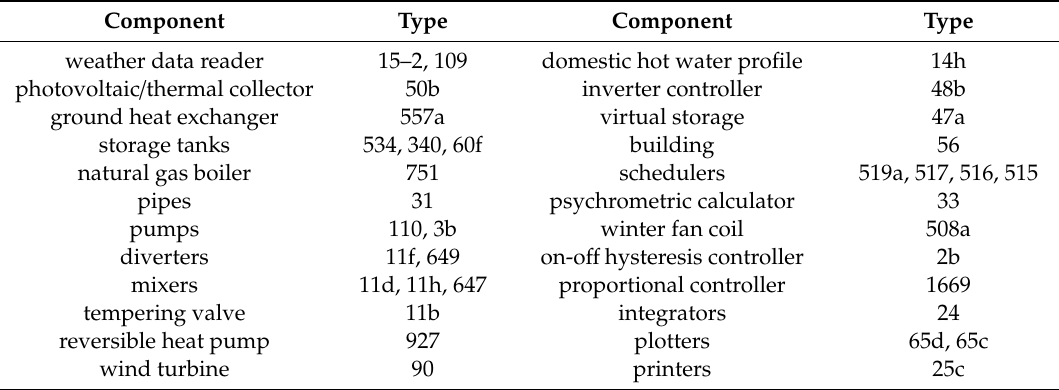
Table 1. List of the built-in components used to develop the hybrid